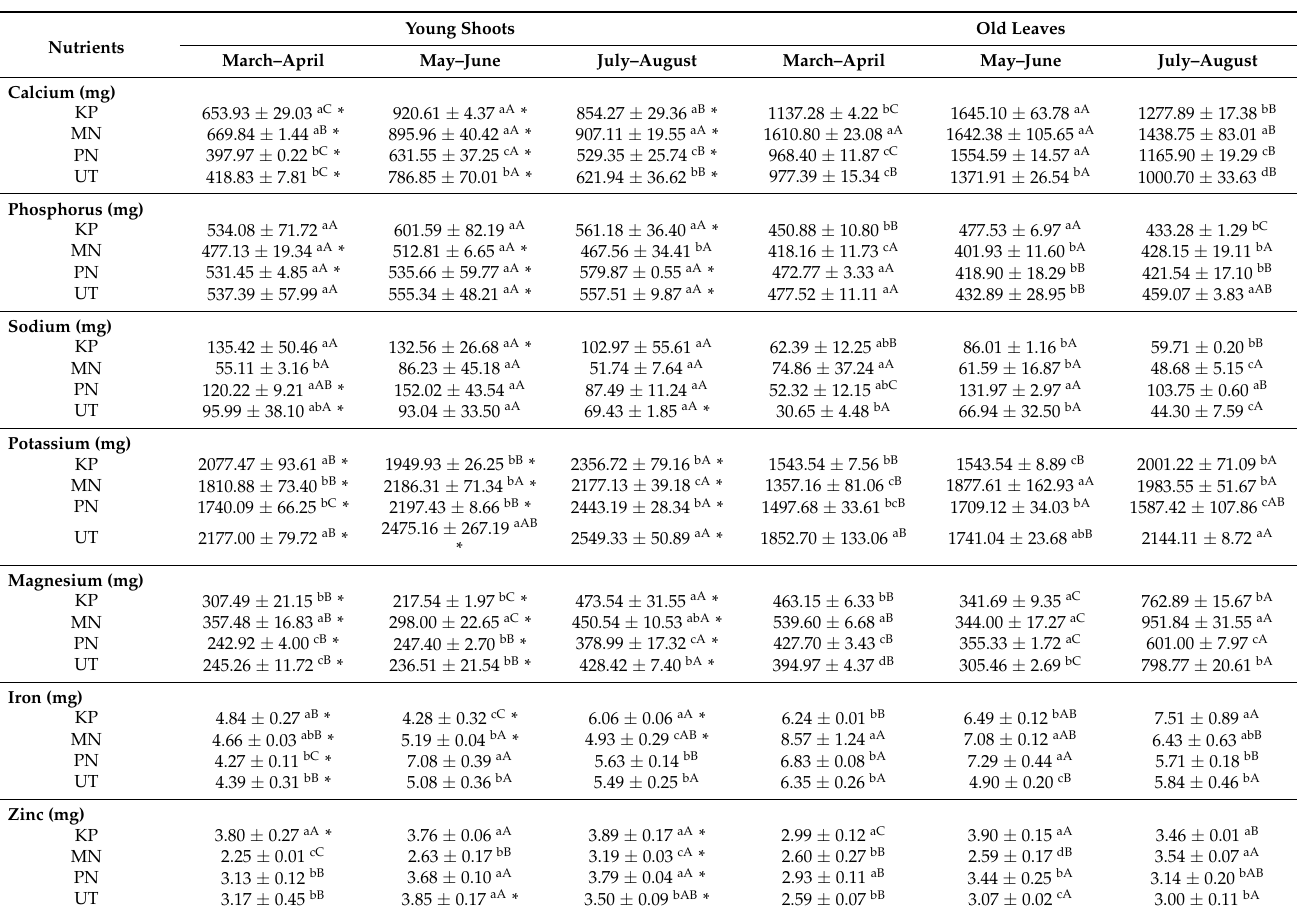
Table 5. Minerals including calcium, phosphorus, sodium, potassium, magnesium, iron, and zinc (per 100 g dry weight) in young shoots and old leaves of Adenia viridiflora Craib. from different origins including Kamphaeng Phet (KP), Muang Nakhon Ratchasima (MN), Pakchong Nakhon Ratchasima (PN), and Uthai Thani (UT) collected in different harvesting